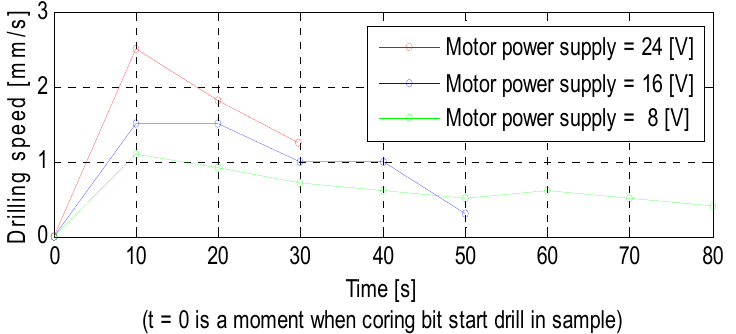
Figure 6. Drilling speed during drillability test performed for Ytong (compression strength Re = 6